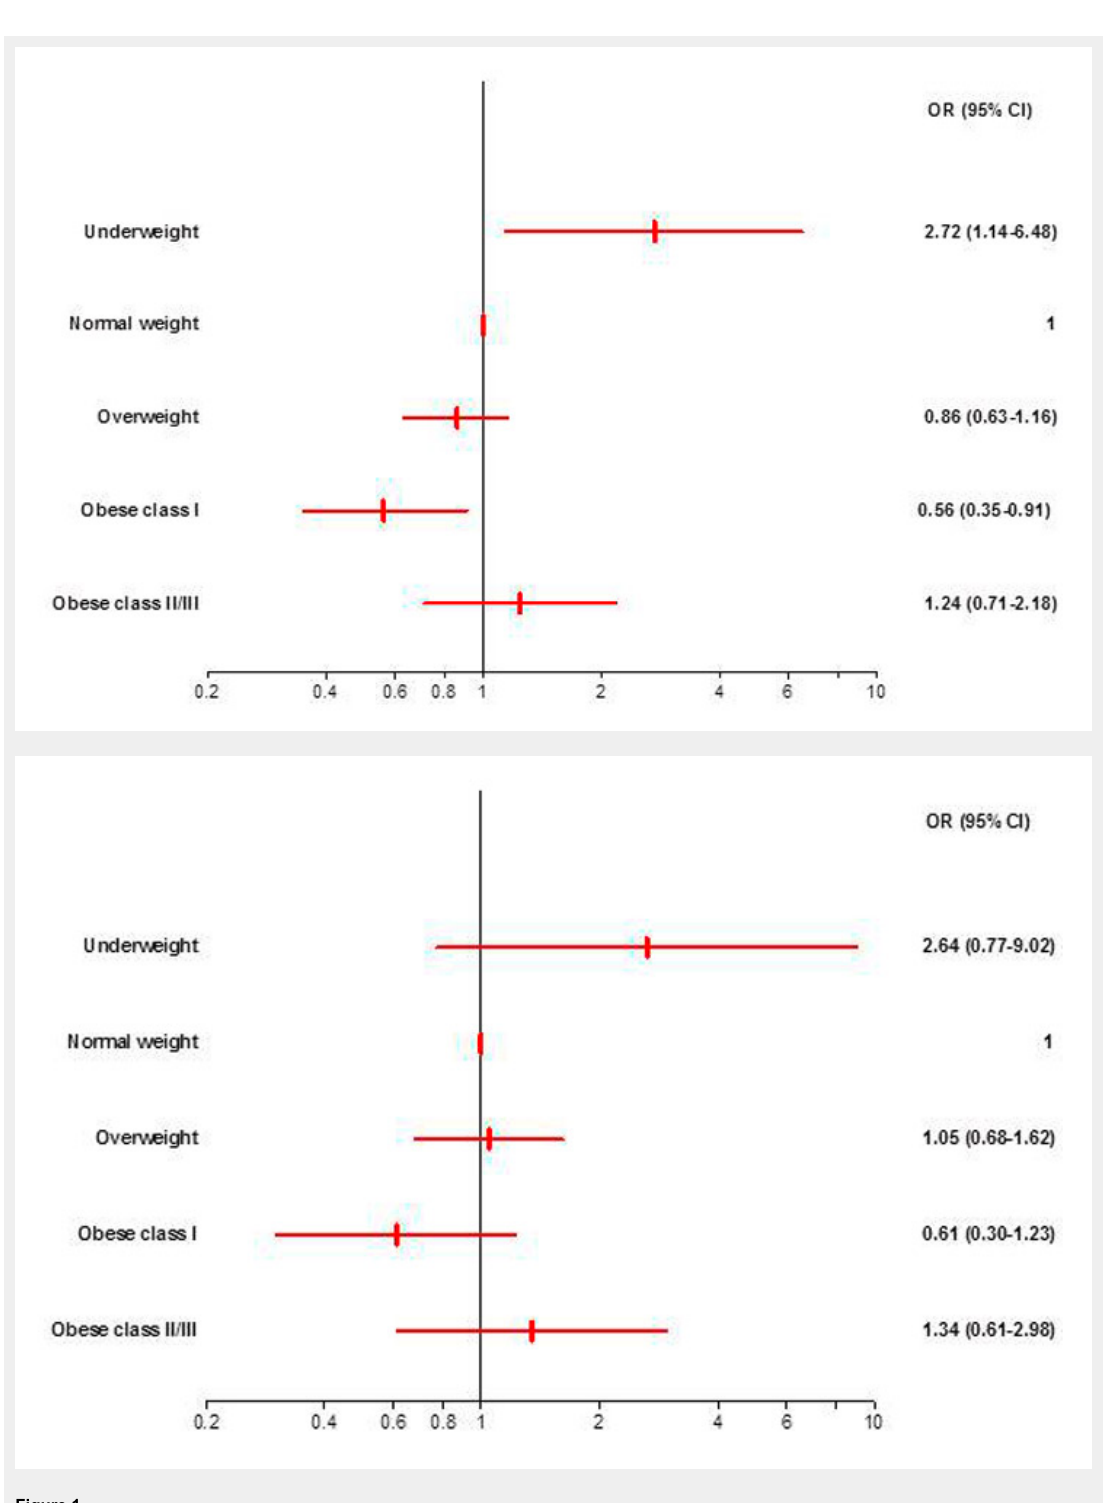
Figure 1 a: Unadjusted odds ratios with 95% CI for in-hospital mortality by BMI categories with normal weight patients as the reference. The odds for in- hospital mortality were significantly higher for underweight and significantly lower for obese class I patients. OR, Odds Ratio. CI, Confidence Interval. b: Adjusted odds ratios with 95% CI for in-hospital mortality by BMI categories with normal weight patients as the reference. None of the BMI groups differed significantly in the odds for in-hospital mortality compared with normal weight patients. OR, Odds Ratio. CI, Confidence